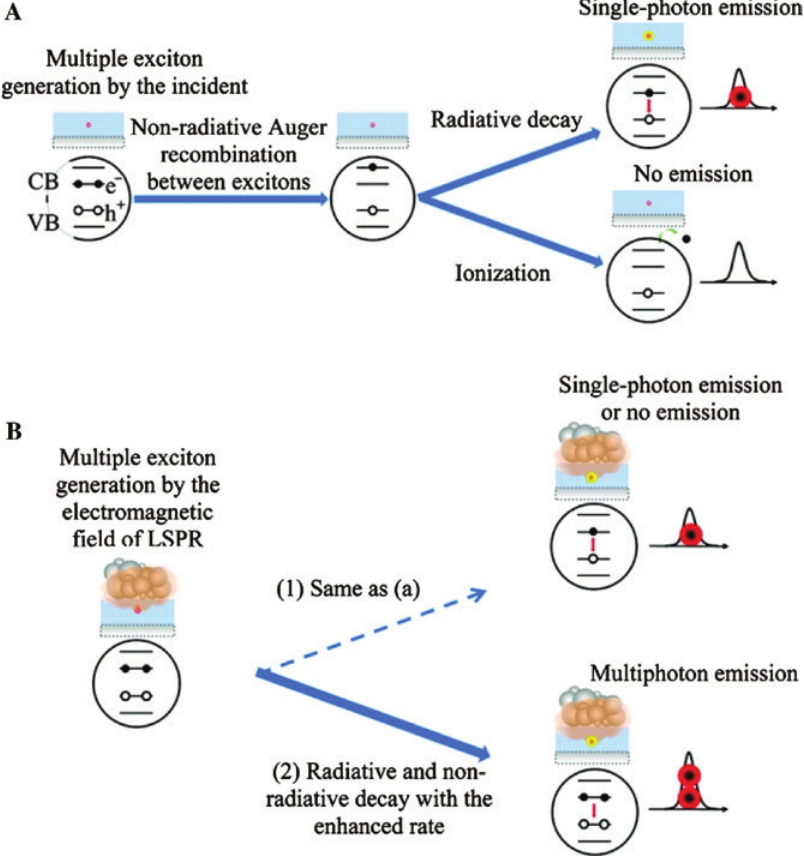
Figure 19: Effect of plasmonic nanoparticles on Auger process in nearby QDs. (A) Depiction of the Auger process in a QD. Two electron-hole pairs are excited. The recombination of one electron-hole pair excites the other electron into a higher-energy state, leading to a loss of observed fluorescence. (B) Influence of PNPs on the Auger process. Reprinted with permission from Ref. [22]. Copyright 2011 American Chemical